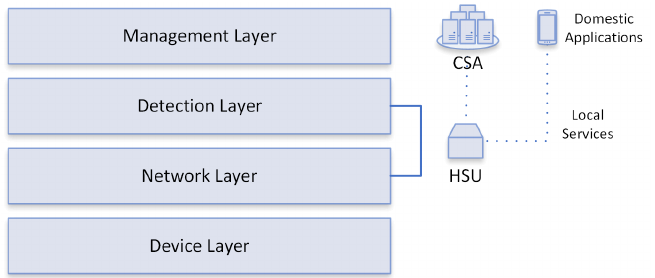
Figure 6. FamilyGuard layers and their relationship with HSU and